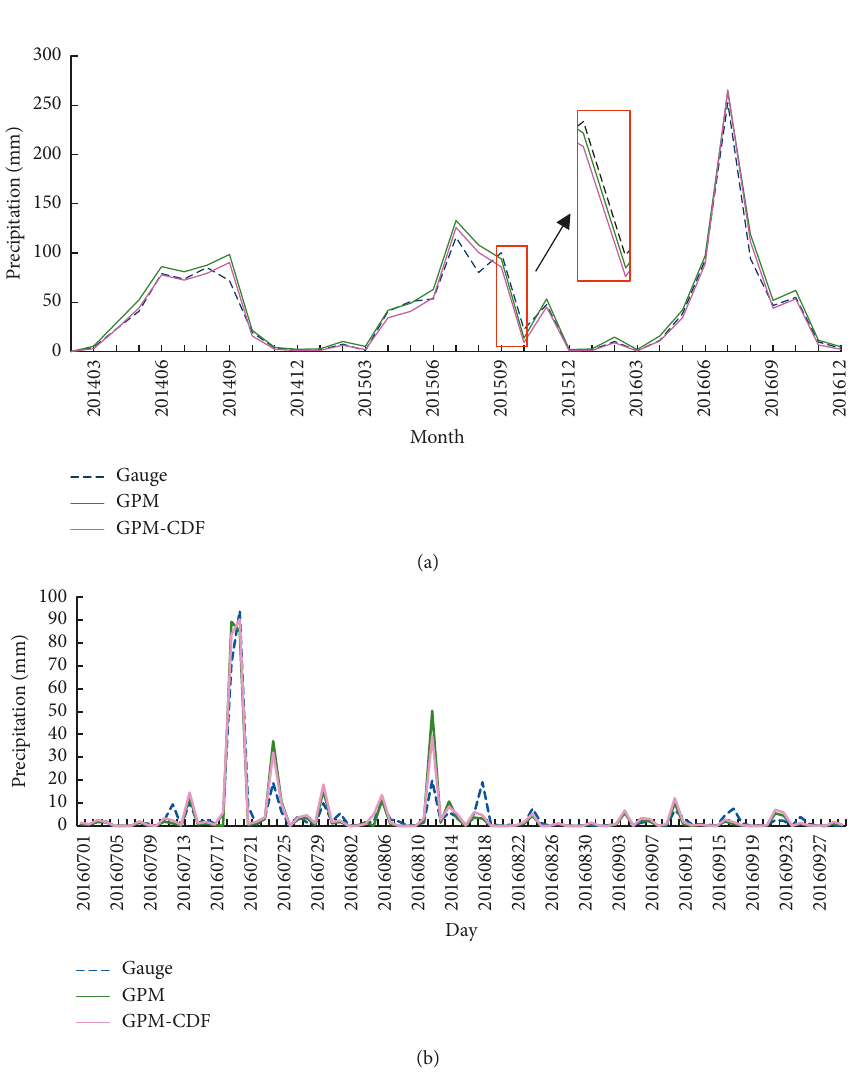
Figure 8: The results of the CDF model. (a) Month and (b)